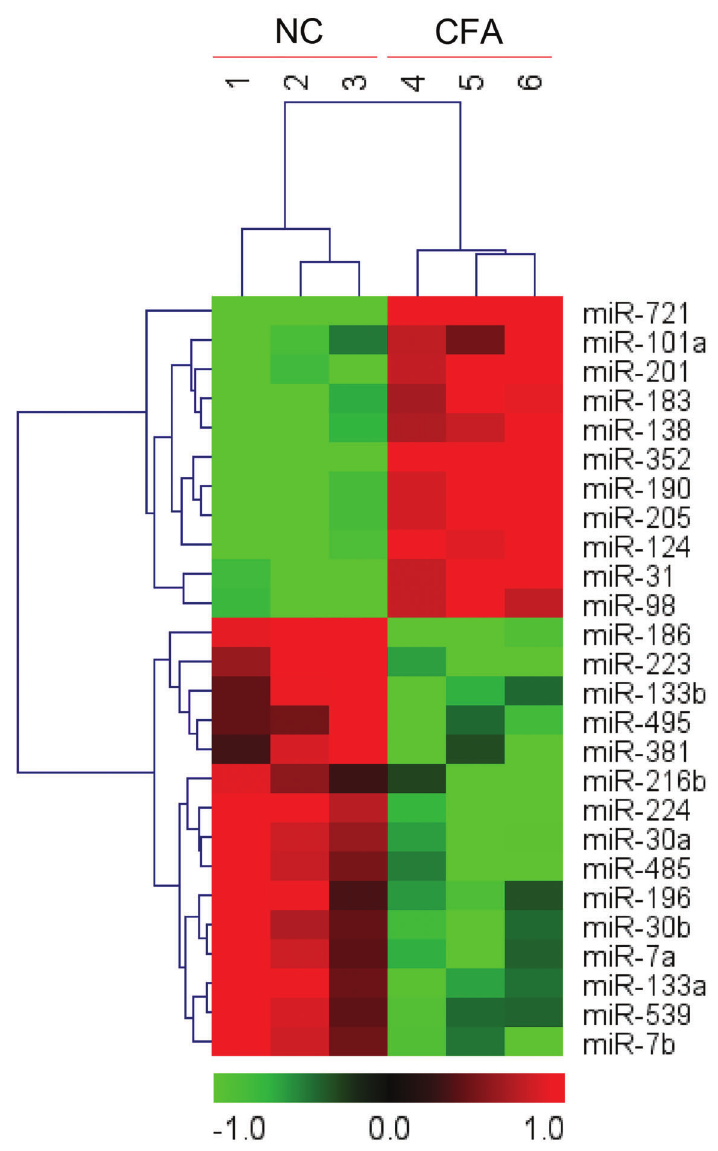
Figure 4. Microarray and hierarchical cluster analysis were performed in trigeminal ganglions (TGs) from complete Freund ’ s adjuvant (CFA)- injected mice and control mice (NC). The fi gure was drawn by MeV software (version 4.2.6; The Institute for Genomic Research (TIGR), USA). Correlation similarity matrix and average linkage algorithms are used in the cluster analysis. Each row represents an individual miRNA, and each column represents a sample. The color legend at the bottom represents the level of miRNA expression, with red indicating high expression levels and green indicating low expression